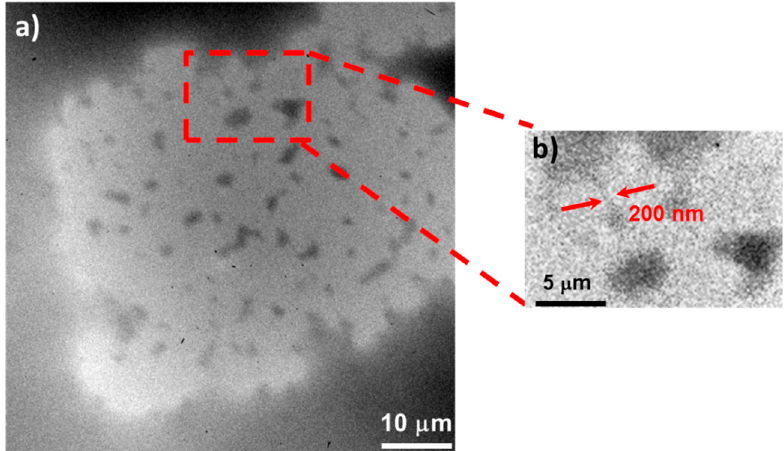
Figure 16. ( a ) Supercoiled pBR322 plasmid DNA, deposited on top of a 50 nm thick Si 3 N 4 membrane, from 100 ng / µ L solution. The zoomed inset in ( b ) shows a 200 nm DNA segment. The image was acquired after 500 SXR pulses (50 s exposure). Figure based on [80].